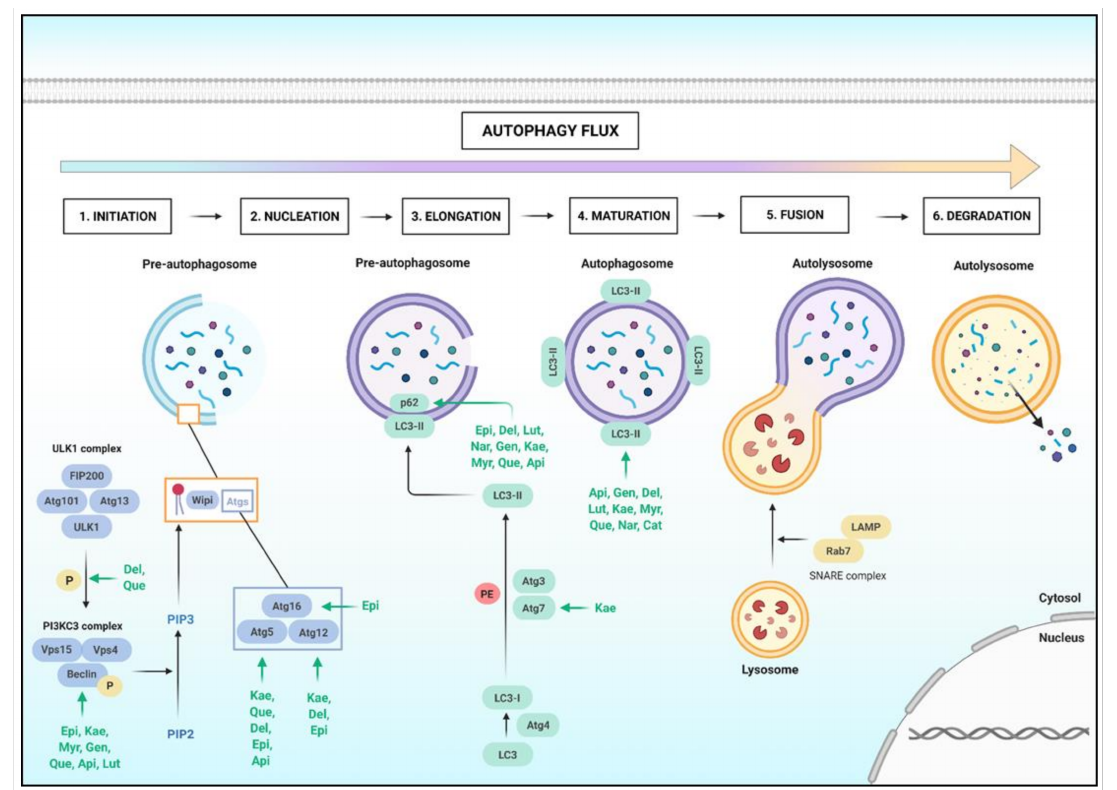
Figure 5. Flavonoids modulate autophagy pathways in cancer. Macroautophagy begins by activation of ULK complex in the endoplasmic reticulum that leads to Beclin1 phosphorylation this permits the activation of PI3KC3 complex that converts PIP2 to PIP3 promoting an accumulation of phospholipid, this accumulation recruits Wipi proteins and some autophagy-related genes (Atg 5,12 and 16) for the formation of the single-layer pre-autophagosome (in blue), the autophagy receptor p62 interacts with the autophagy target and binds to active LC3-II forming a mature double membrane (in purple) that is fused with lysosomes that will digest the autophagosome content with cathepsin enzyme. Flavonoids can stimulate macroautophagy, through the increase in expression of Beclin1, p62, LC3-II, and some Atgs. Kae: Kaempferol, Myr: Myricetin, Que: Quercetin, Api: Apigenin, Gen: Genistein, Del: Delphinidin, Lut: Luteolin, Nar: Naringin, Epi: Epigallocatechin. Original figure made for this review using the Biorender